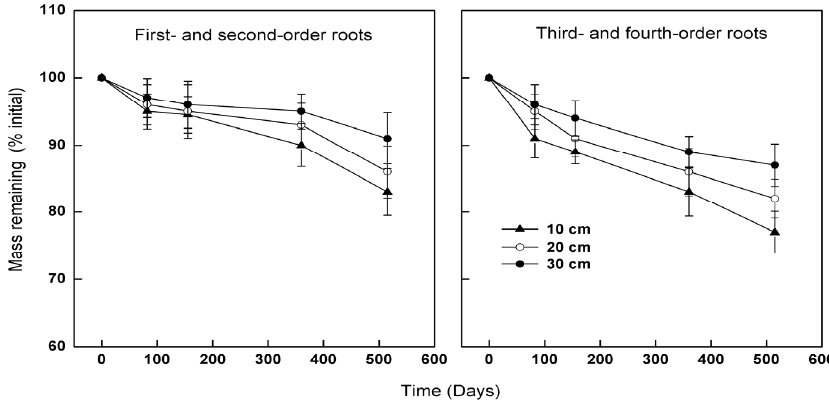
Figure 1. Effects of root order and soil depth on mass remaining (% initial) of Larix gmelinii during 17 months of exposure in field. Error bars represent ± SE ( n = 3). Table 2. Decomposition rate coefficients obtained by fitting a linear decomposition model to Larix gmelinii root data at three soil depths after 17 months of field exposure.